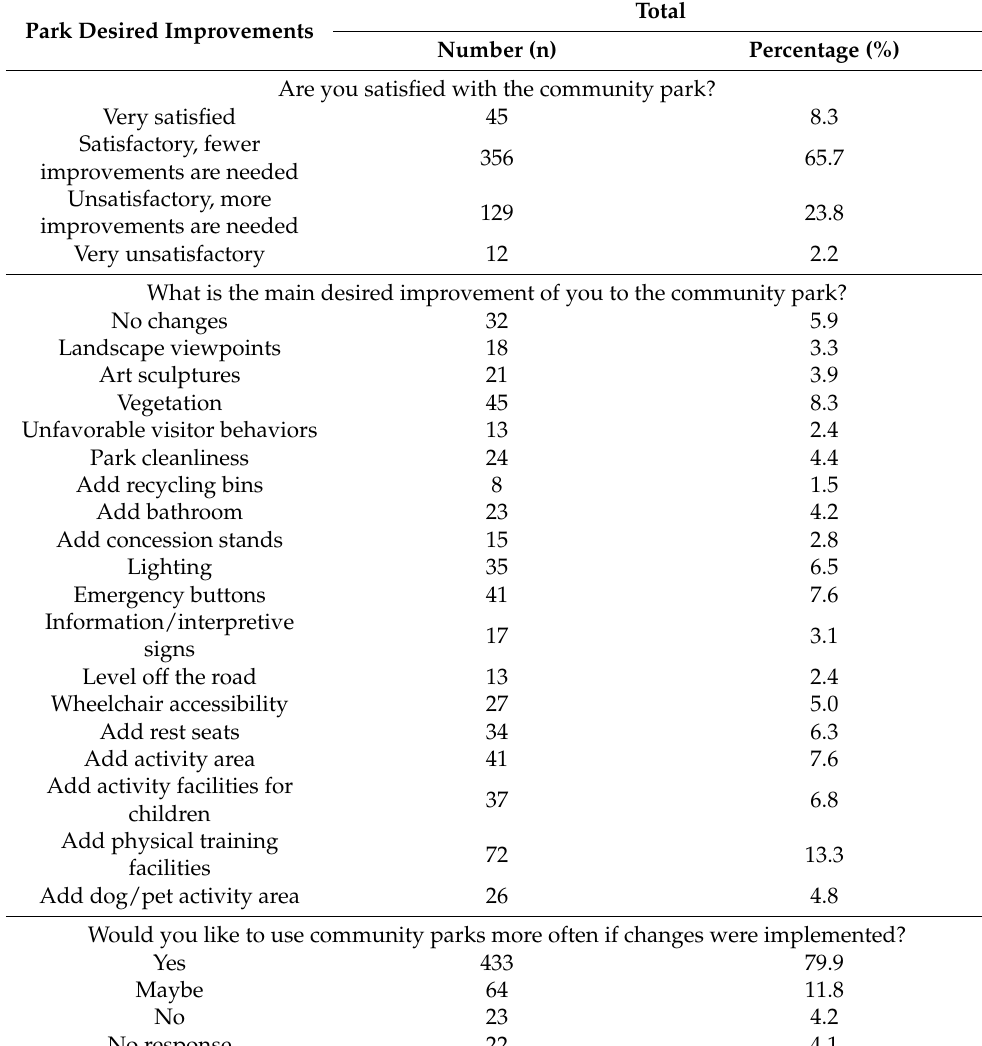
Table 4. Analysis of visitors’ desired